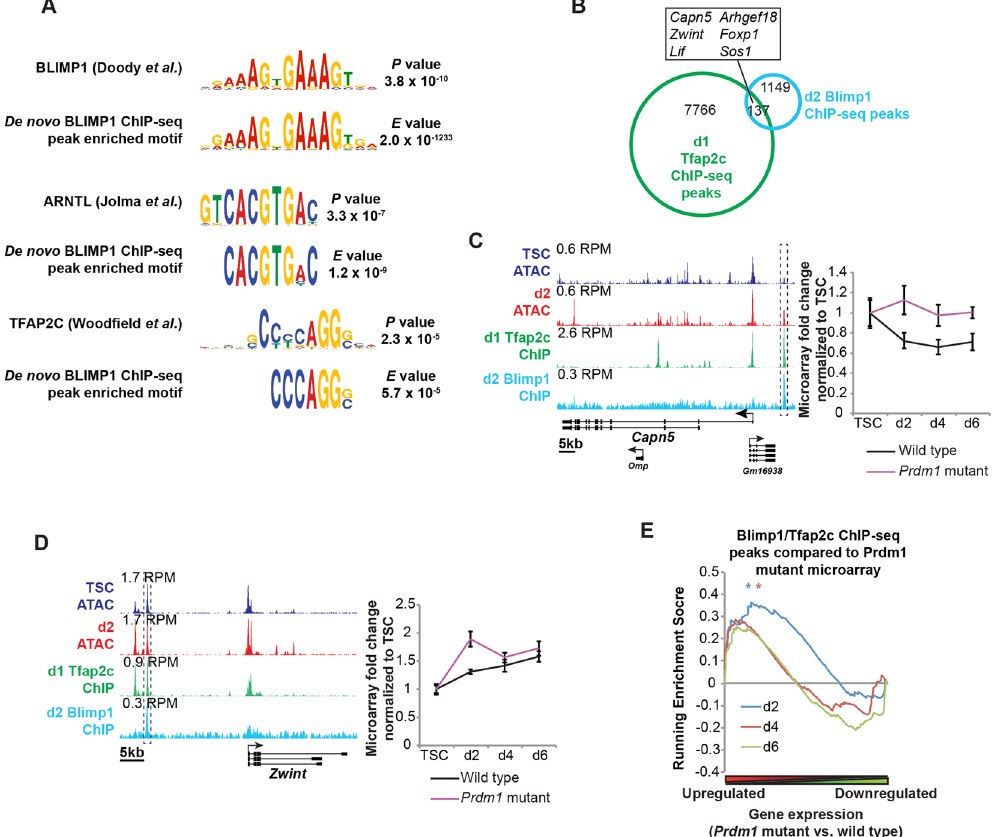
Figure 5. A subset of Blimp1-bound regions may also display Tfap2c occupancy. ( A ) MEME-ChIP analysis of d2 Blimp1 ChIP-seq peaks identified multiple transcription factor binding motifs 89, 91, 92 . E value confidence scores for de novo motif identification and P value for match to published motif are shown. ( B ) Overlap of d2 Blimp1 and d1 Tfap2c ChIP-seq peaks. Examples of genes occupied by both Blimp1 and Tfap2c at overlapping coordinates ± 100 kb of their TSS are indicated. See also Supplementary Figure S2. ( C , D ) Comparison of ATAC- seq and ChIP-seq peaks showing Blimp1 and Tfap2c occupancy at Capn5 ( C) and Zwint ( D ), with microarray expression profiles. Fold change relative to TSC is shown. Data represents means ± S.E.M., n ≥ 6 per genotype per stage. RPM = Reads per million. Gene Set Enrichment Analysis comparing overlapping Blimp1/Tfap2c ChIP-seq peaks and microarray changes in gene expression during TSC differentiation. * P < 5 × 10 − 2